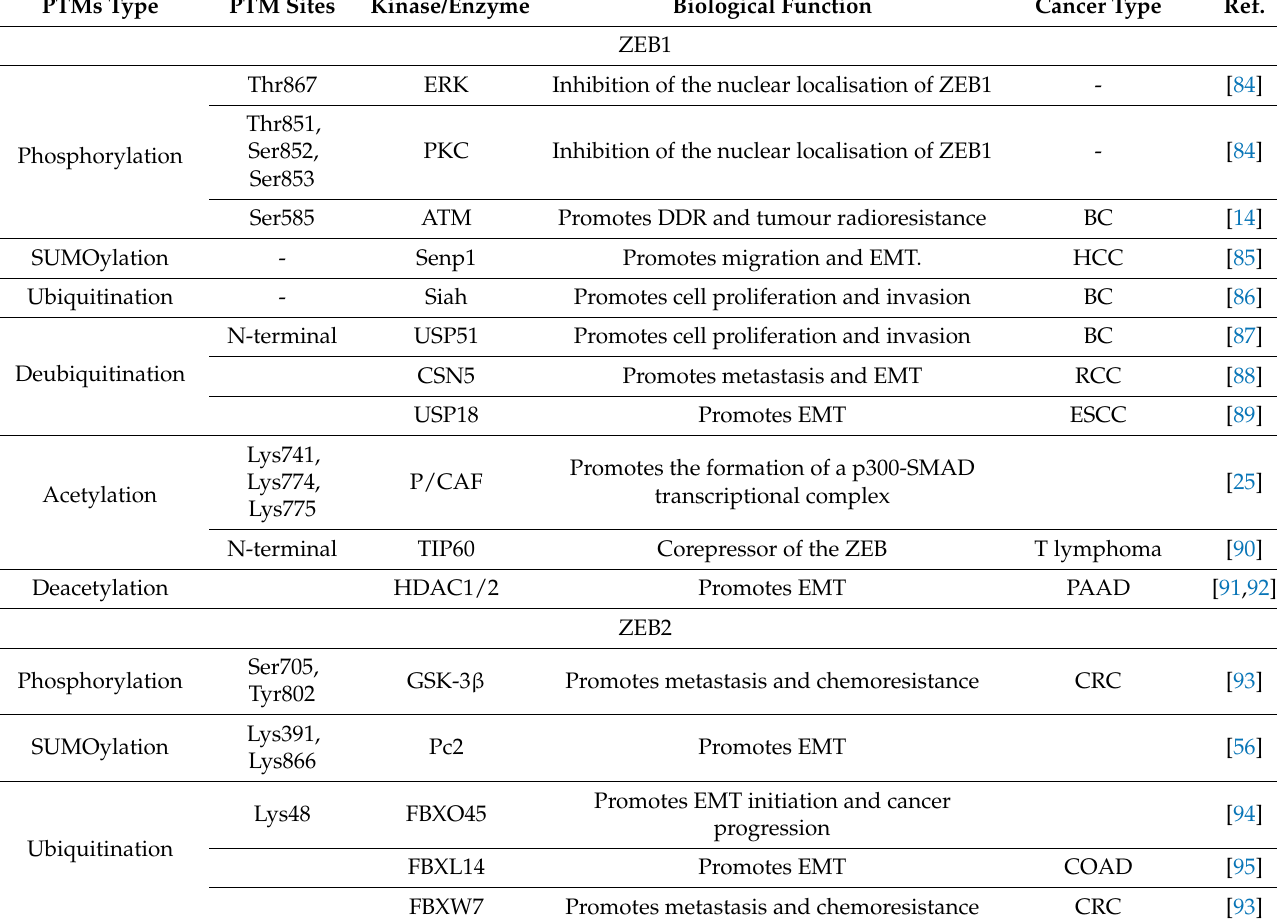
Table 1. Functions of